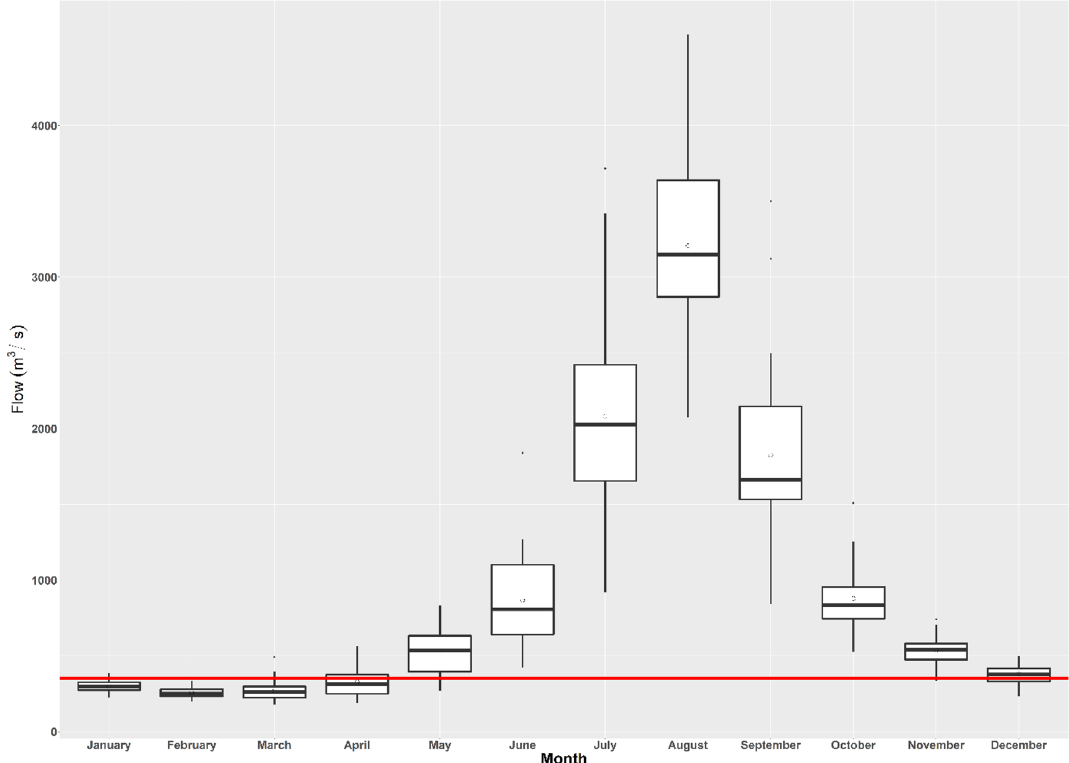
Figure 7. Monthly average 90% time equalled or exceeded flows for the 39 years shows that from January through April, aquatic species suffer from low flows, putting them at risk of evolutionary traps by hugely reducing suitable hydro-physical habitats. The horizontal red line indicates the lower limit of the optimum